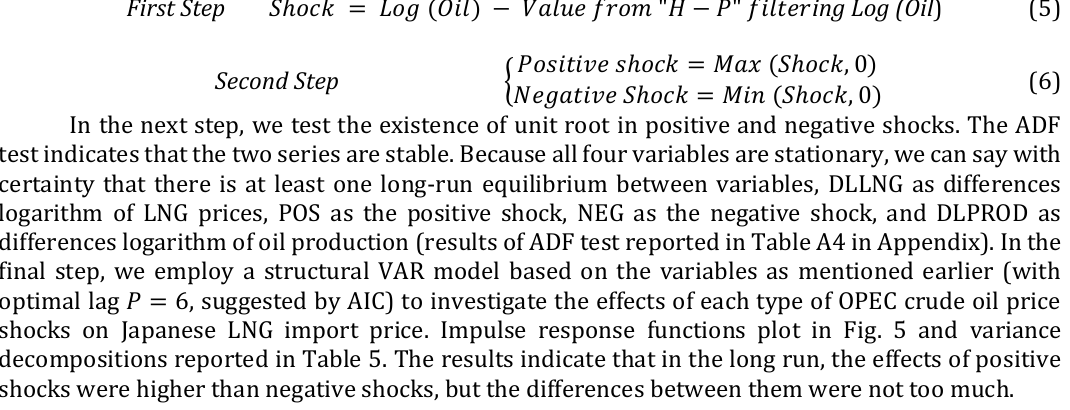
Figure 5: Impulse responses of structural shocks to LNG prices/ Hodrick-Prescott filtering